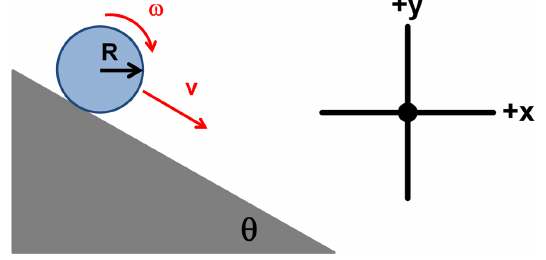
FIG. 11. A sphere with radius R is rolling without slipping down a ramp. The coordinate system defines an x axis parallel to the horizontal surface of the ramp and a y axis parallel to the vertical surface of the ramp. The positive direction for the x axis points to the right and the positive direction for the y axis points upwards. The angle of the ramp with respect to the x axis is θ .